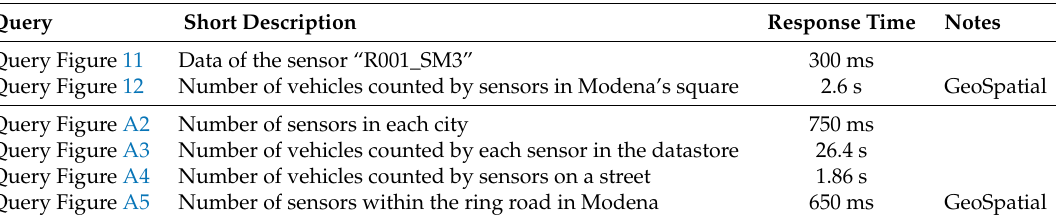
Table 4. SPARQL queries response